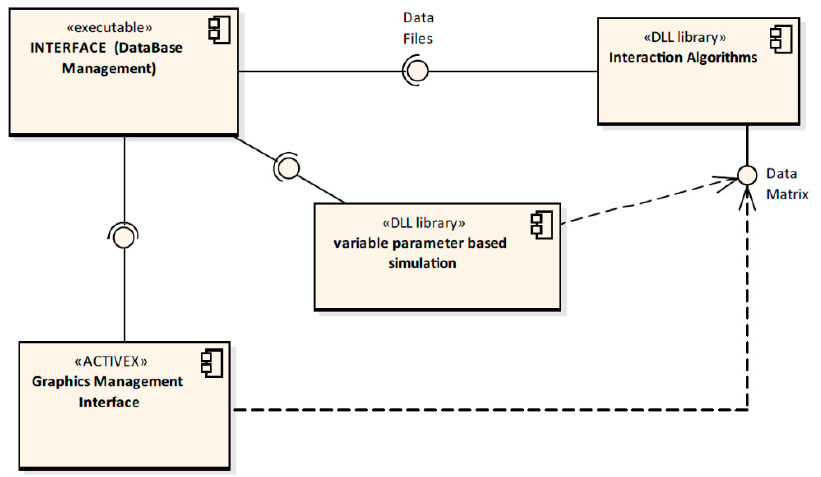
Figure 8. Component diagram of the RICATI application.